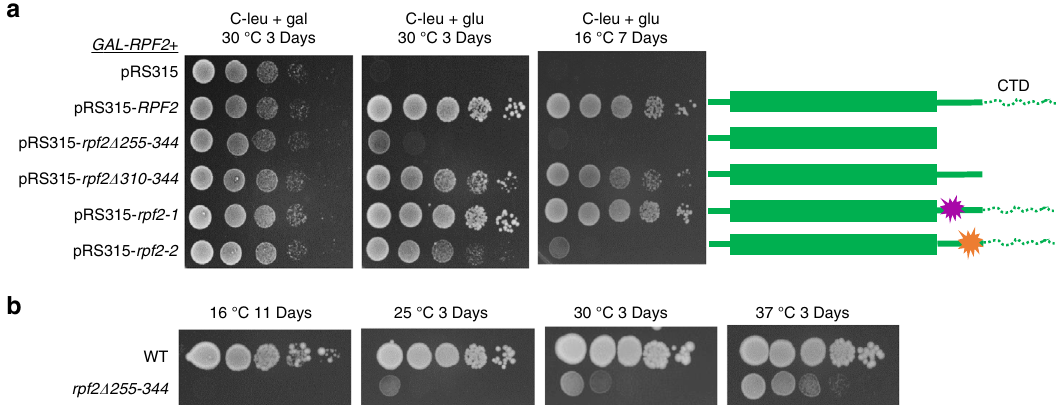
Fig. 1 The CTD of Rpf2 is essential for cell growth at 16 °C. a Left: growth of yeast strains containing truncated or mutated Rpf2 protein on solid medium. Serial dilutions (1 : 10 to 1 : 10,000) were spotted onto selective solid medium containing either galactose or glucose and incubated at 30 °C and 16 °C. Right: schematic representation of truncations and mutations introduced into the CTD of Rpf2. Amino acids 301 – 344 are represented by dashed lines. b Growth of yeast strain containing the genomic allele of rpf2 Δ 255-344 and its wild-type control. Serial dilutions (1 : 10 to 1 : 10,000) were spotted onto solid medium and incubated at 16, 25, 30, and 37 °C. Source data are provided as a Source Data fi